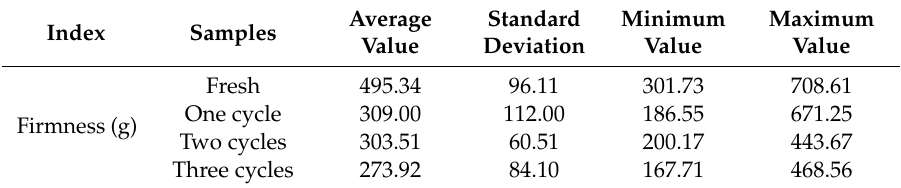
Table 7. Firmness value of Nanguo